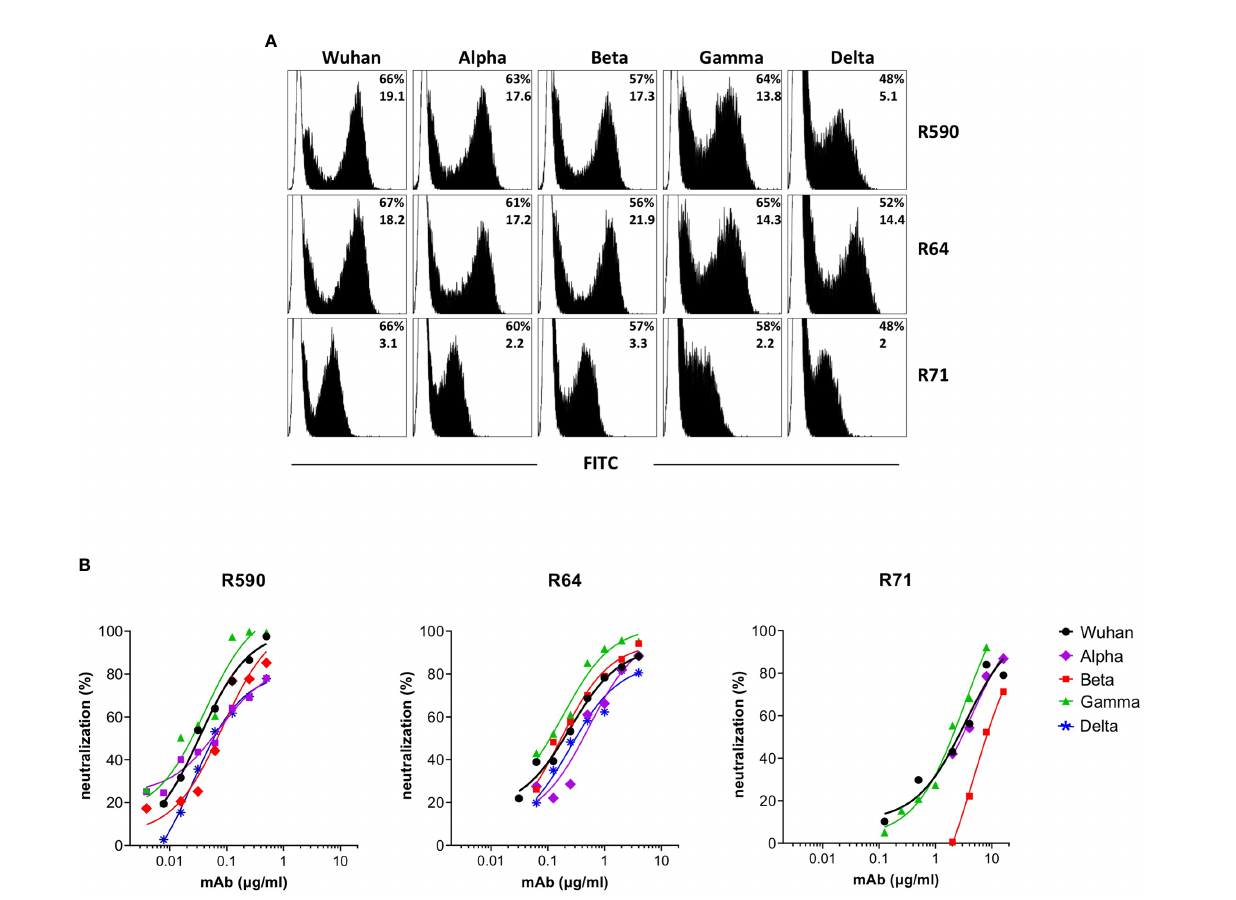
FIGURE 5 | Binding and neutralization potency of anti-RBD mAbs against Wuhan and VOC. (A) HEK293T cells transfected with plasmid coding for wild type transmembrane homotrimeric spike of Wuhan or VOC were stained with R590, R71, R64 neutralizing anti-RBD mAbs (black histograms), or with murine IgG1 control mAb (white histograms) followed by goat anti-mouse FITC-conjugated mAb and analysed by fl ow cytometry. The upper numbers indicate the percentages of positive cells, lower numbers indicate mean fl uorescence intensity. A representative experiment is shown. (B) Neutralization curves obtained by using LV pseudotyped with spike of Wuhan or its Alpha, Beta, Gamma and Delta VOC testing serial dilutions of isolated R590, R64 and R71 mAbs. Data are mean representative of three independent experiments each with two technical